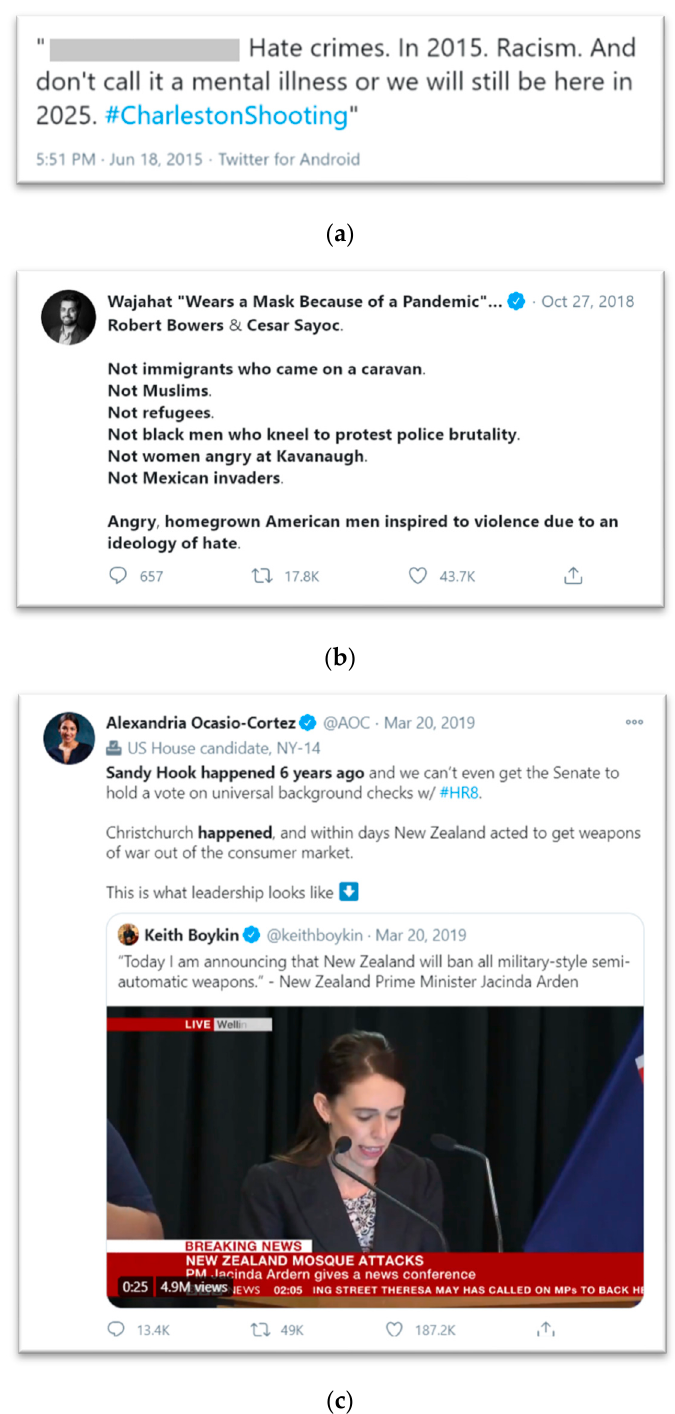
Figure 1. Most liked and retweeted tweet in each dataset. ( a ) Most liked and retweeted tweet in the Church massacre dataset by an entertainer (tweet currently deleted). ( b ) Most liked and retweeted tweet in Synagogue dataset by Political Commentator Wajahat Ali (2018). ( c ) Most liked and retweeted tweet in the Mosque dataset by Politician Alexandria Ocasio-Cortez (2019). Influencers